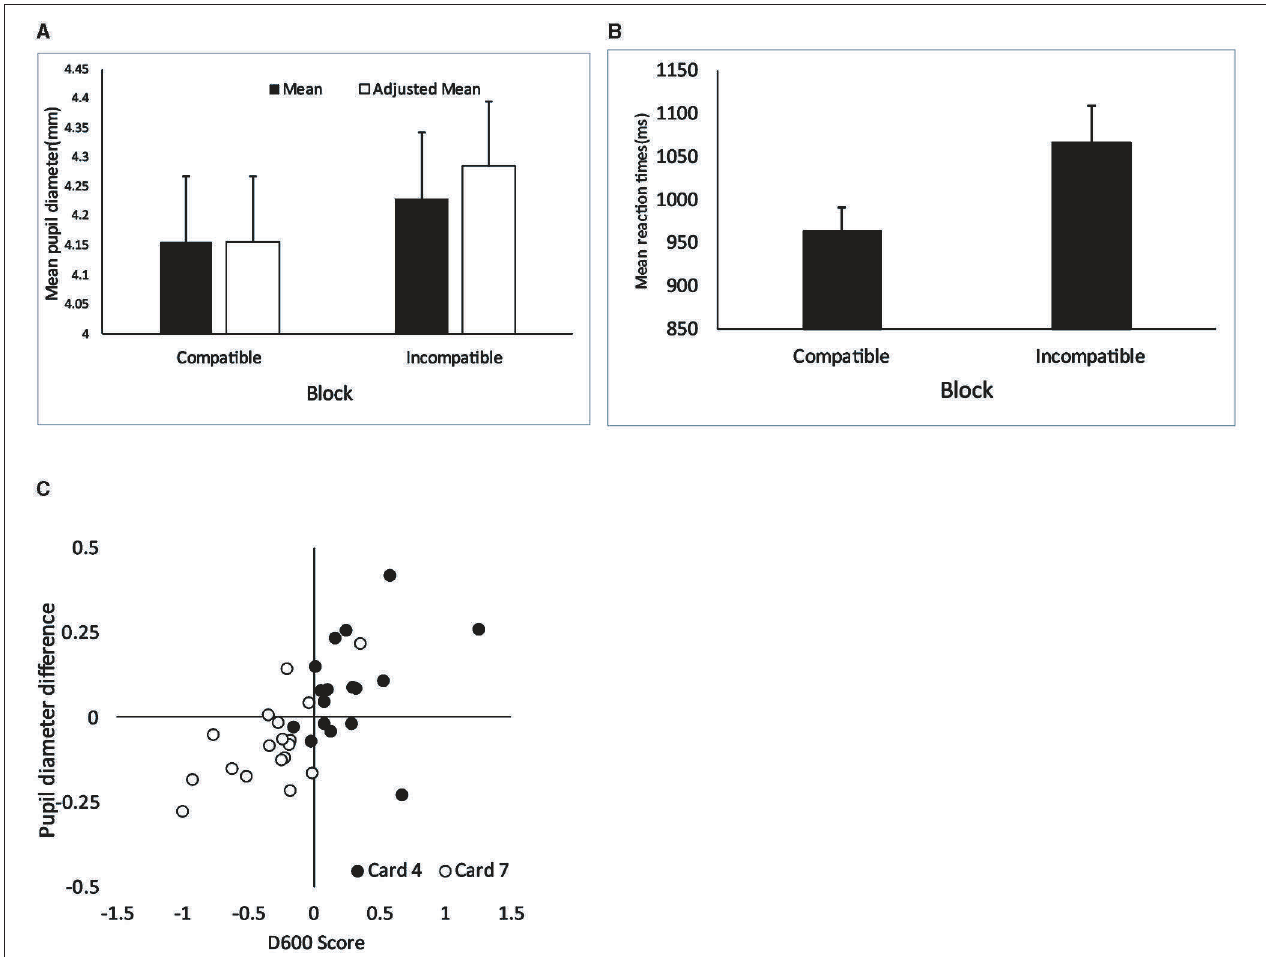
FIGURE 1 | (A) Block mean pupil diameter and the adjusted block mean pupil diameter (means of initial 25 s in each block). (B) Block mean reaction time, which is rescaled from the log-transformed value. Standard errors based on the non-transformed, original value. (C) Relationship between pupil and behavioral measures. The pupil measure is the difference in mean pupil diameter (Block 7–Block 4). Bars indicate standard errors. Behavioral measure (reaction time) is expressed as the D 600 score. Positive values imply smaller pupil diameter and faster response in Block 4 (the four of diamonds + true block) than in Block 7 (the seven of clubs + true